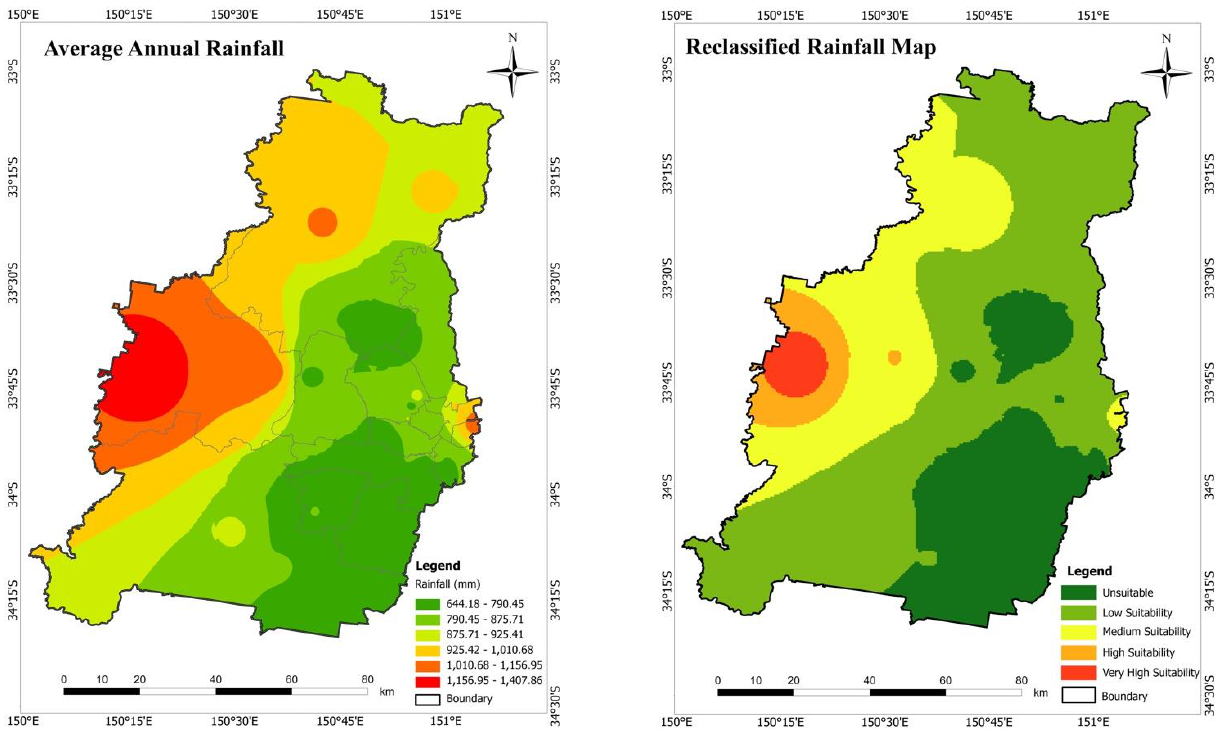
Figure 7. Rainfall map of the study area average annual rainfall ( left ); reclassified rainfall ( right ).